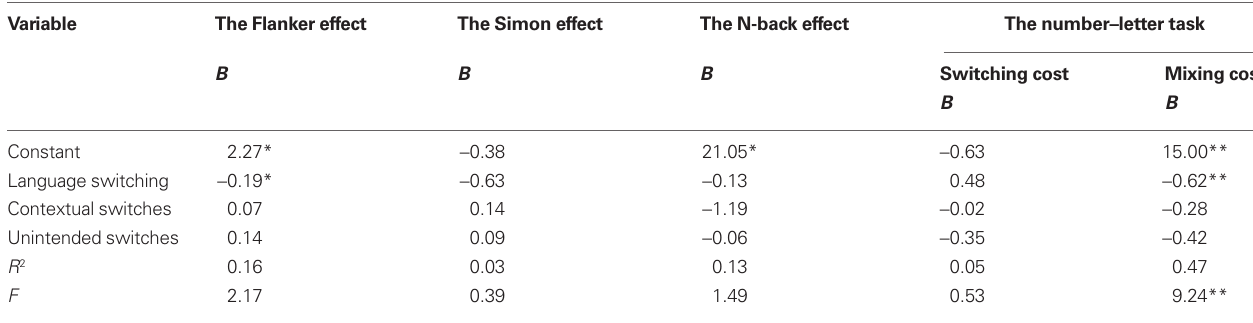
Table 7 | Summary of the multiple regression analyses: BSWQ variables as predictors of processing cost in errors on the executive tasks. Variable